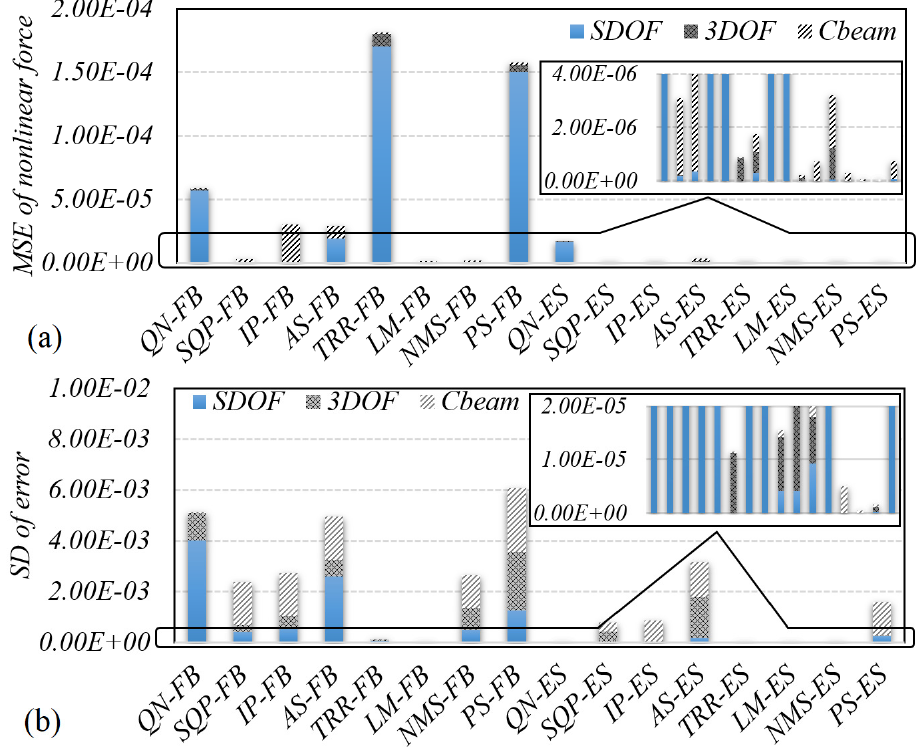
Figure 8. Accuracy of the delivered model using different optimisation methods in predicting the response ( a ) MSE of nonlinear force; ( b ) standard deviation (SD) of